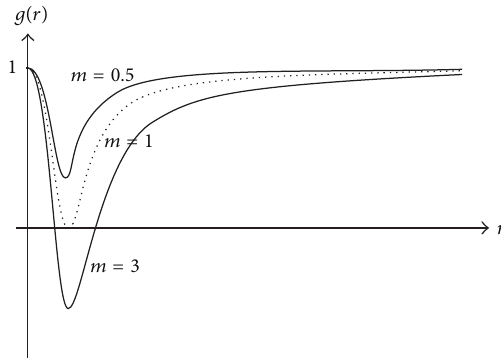
Figure 1: The metric function 𝑔(𝑟) for de Sitter-Schwarzschild spacetime; 𝑚 = 𝑀/𝑀 crit